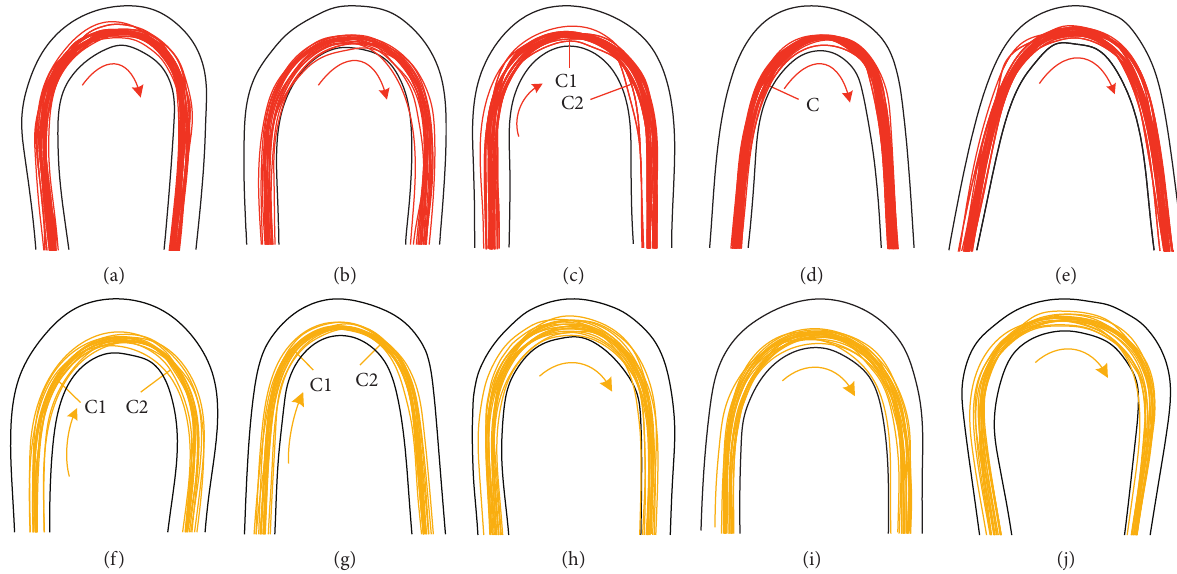
Figure 5: Right-turning traveling tracks at the hairpin curves. (a) Turn 1. (b) Turn 2. (c) Turn 3. (d) Turn 4. (e) Turn 5. (f) Turn 6. (g) Turn 8. (h) Turn 9. (i) Turn 10. (j) Turn 11.